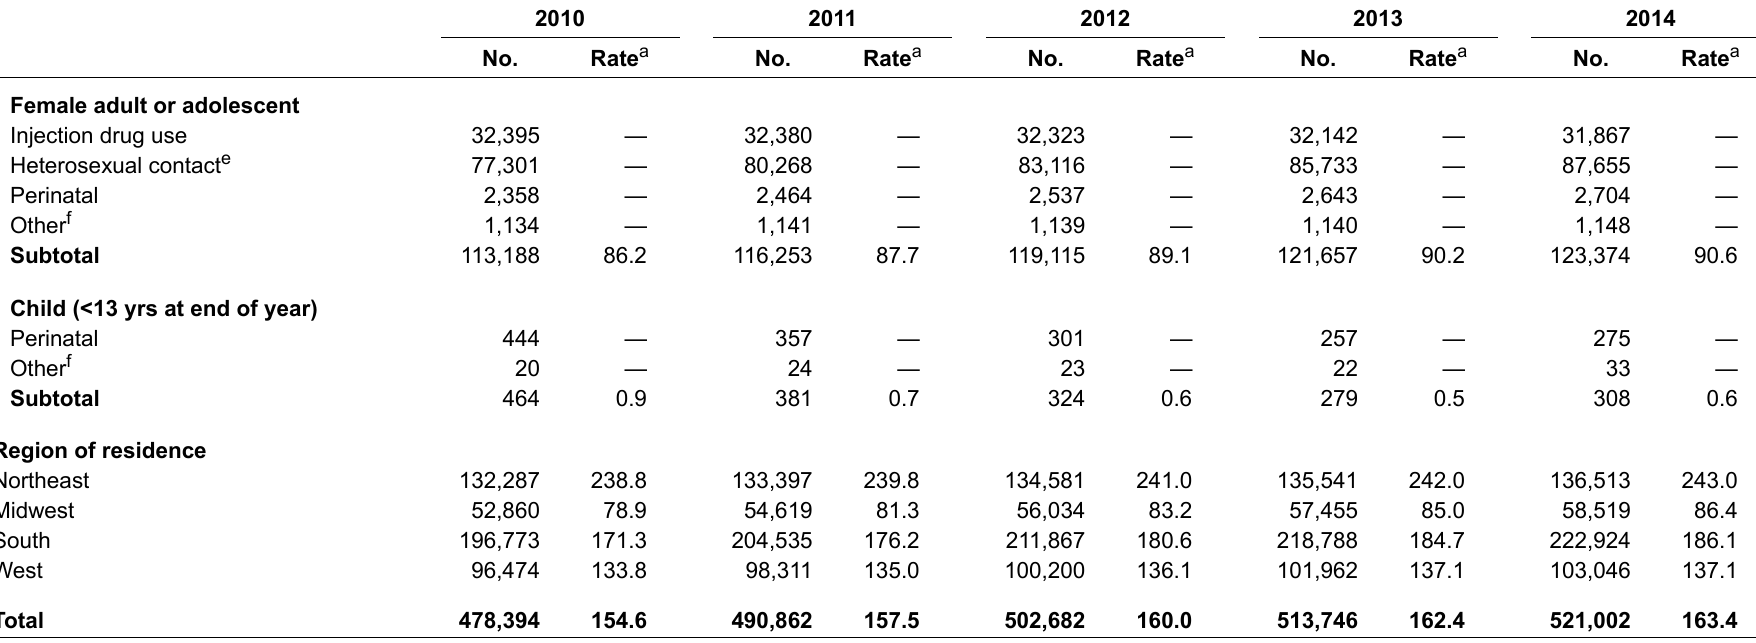
Table 19a. Persons living with diagnosed HIV infection ever classified as stage 3 (AIDS), by year and selected characteristics, 2010–2014—United States